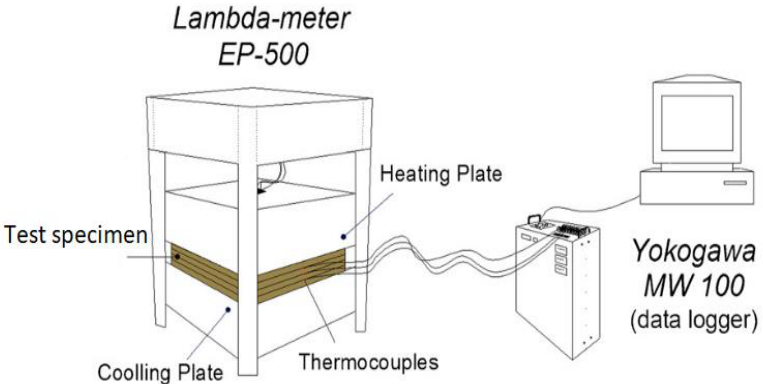
Figure 7. Schematic of a single specimen guarded hot plate apparatus connected to a data logger. Adopted from Tadeu et al. [52].